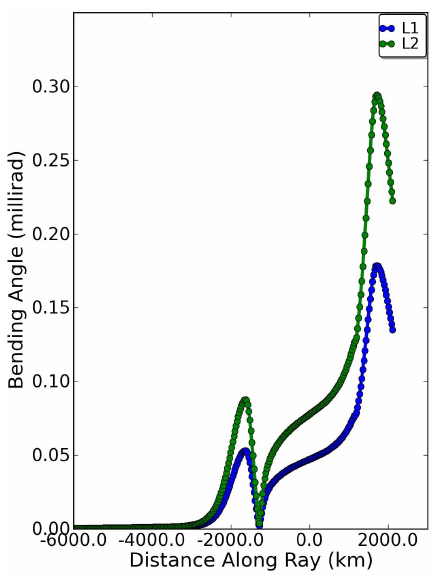
Fig. 4. Bending angle along the ray for the L1 and L2 frequencies, assuming IRI electron density distribution extrapolated linearly to zero below 100km. Bending angle is relative to the direction that the ray leaves the